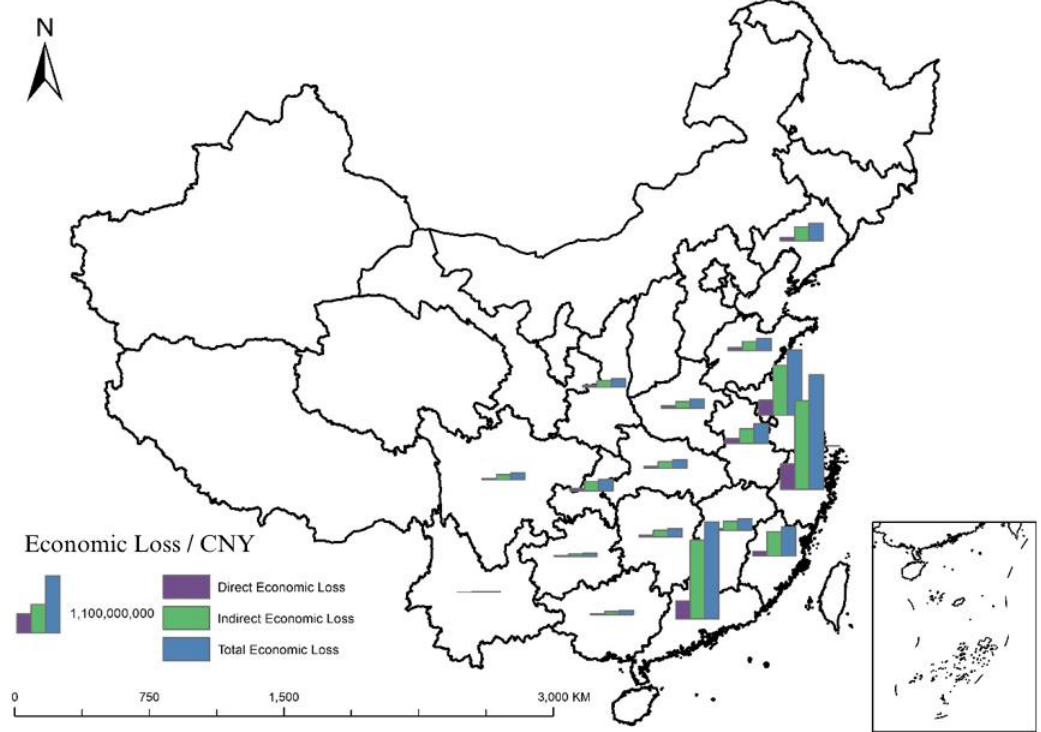
Figure 4. Average economic losses of pine wood nematode disease in mainland China from 1998 to 2017.